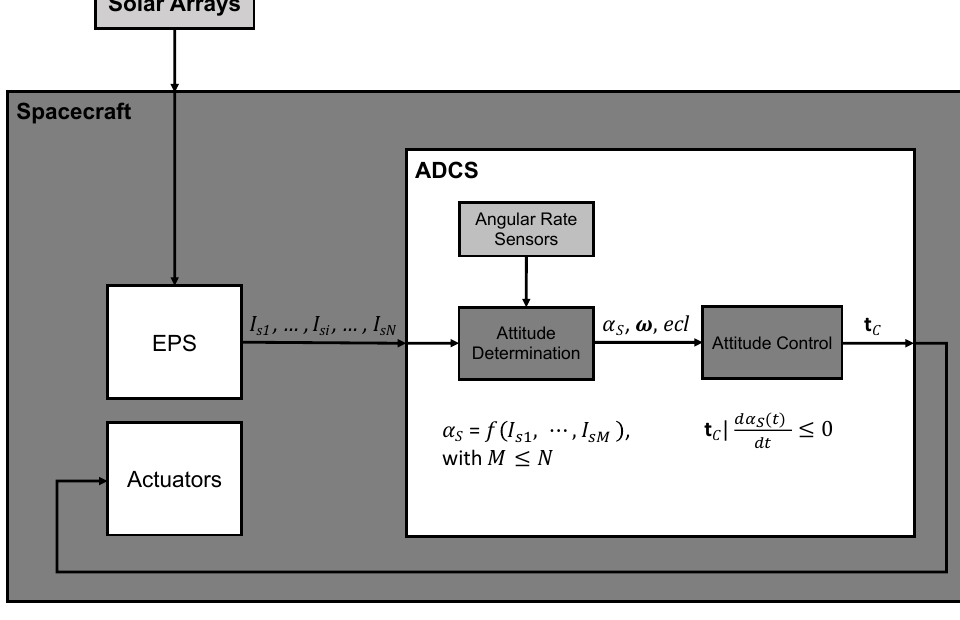
Figure 2. Solar arrays pointing ADCS scheme, with data interfaces and visual algorithm